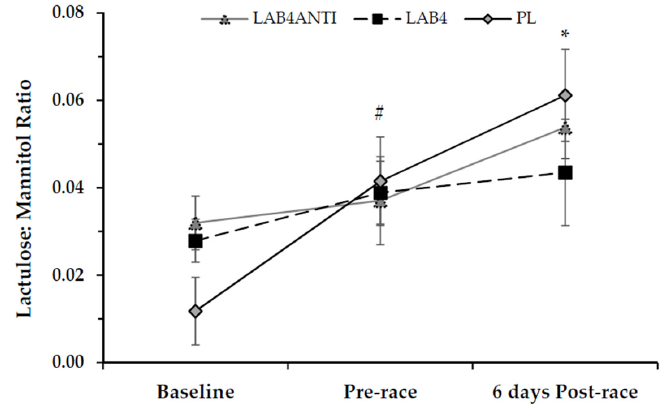
Figure 2. Assessment of intestinal permeability via urinary lactulose:mannitol ratio (Mean ± SE). Values measured in mmol · L − 1 . # denotes significant increase from baseline for PL only ( p = 0.05); * denotes significant increase from baseline for PL only ( p = 0.002).